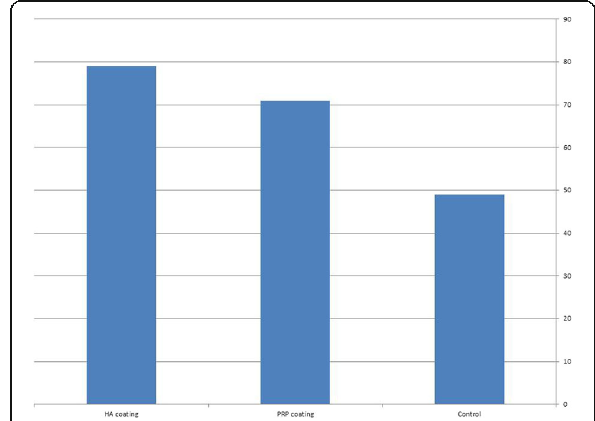
Fig. 4 Bone implant contact of different test